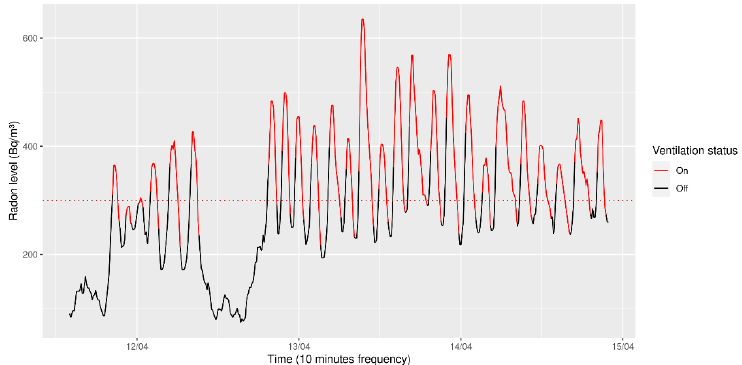
Figure 11. Real time operation of the Radon Control System.